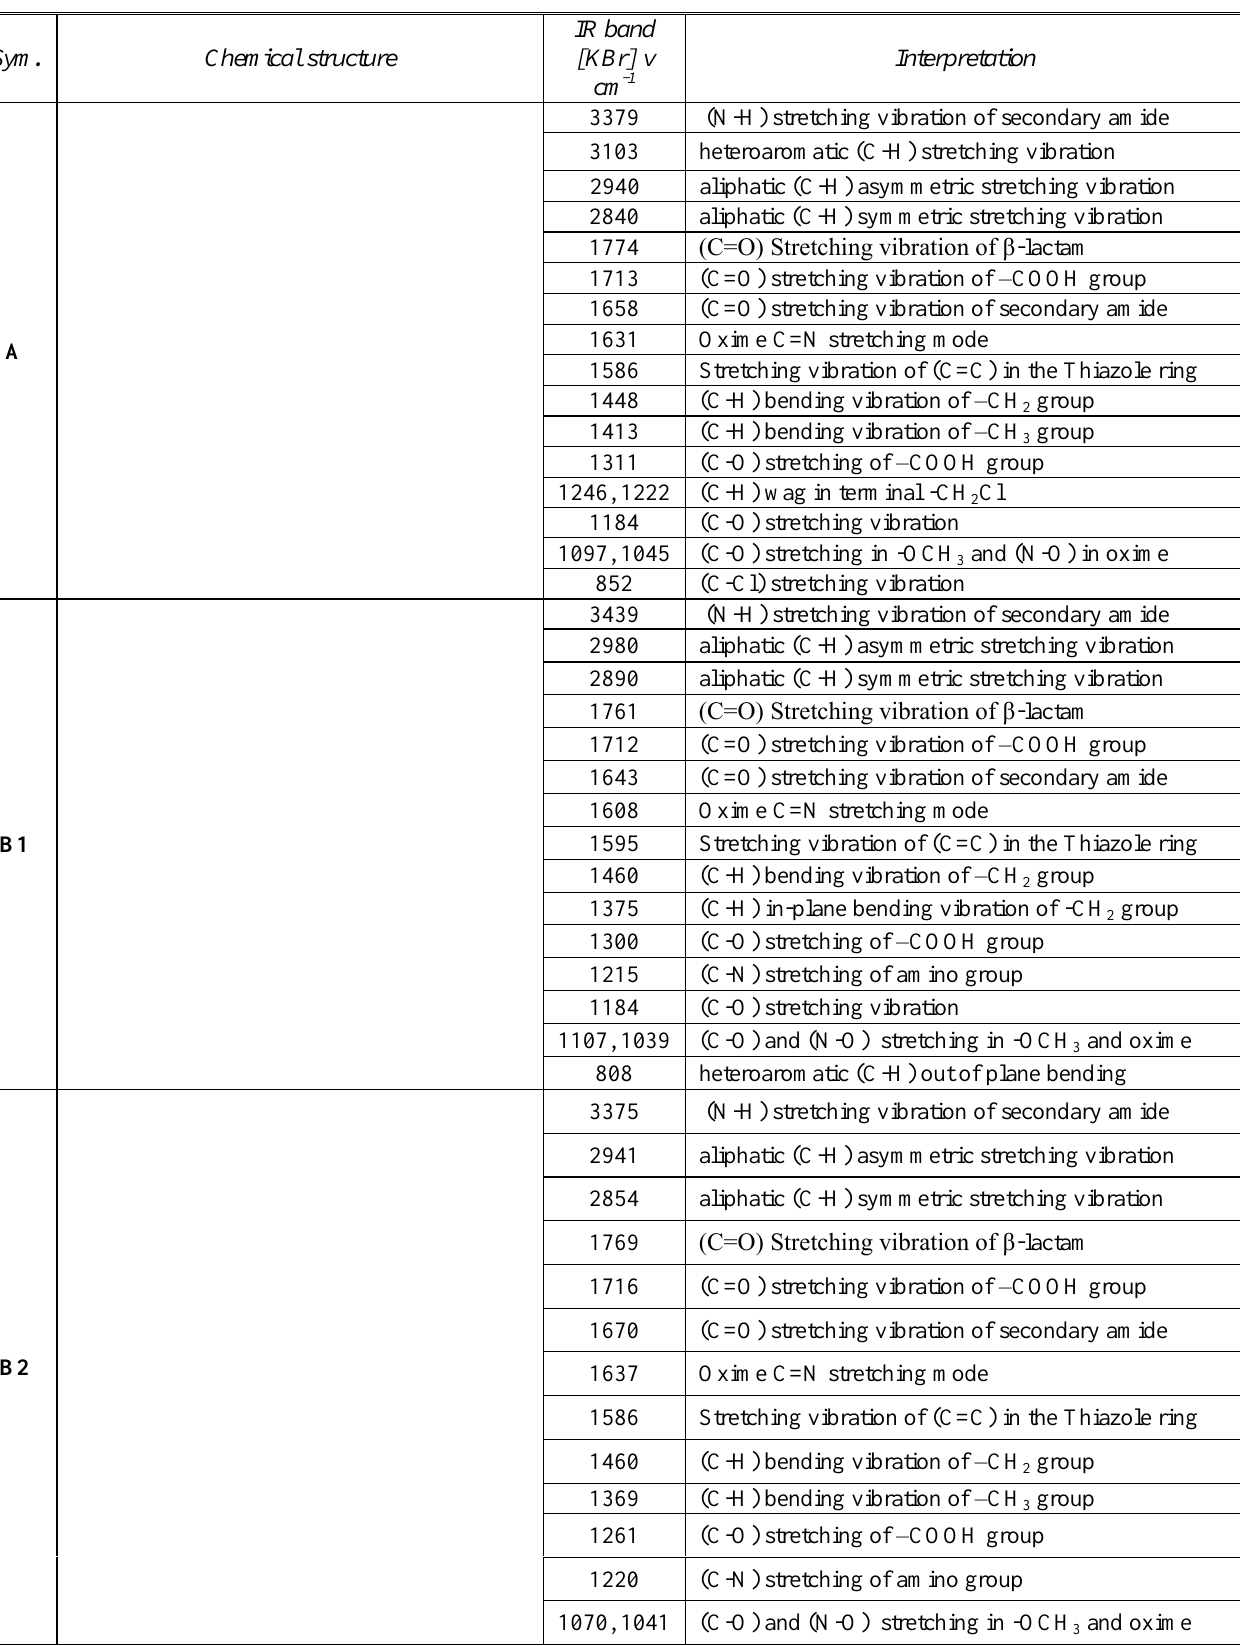
Table (3): The characteristic IR bands of the synthesized intermediate (A) and target compounds (B1-B7).